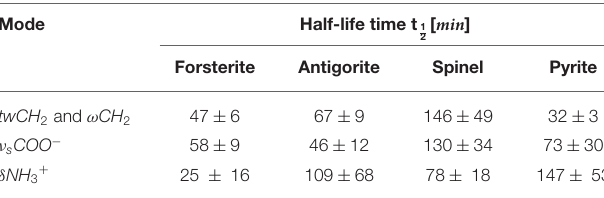
TABLE 9 | Comparison of half-life of GLY adsorbed on forsterite, antigorite, spinel, and pyrite for three common bands.